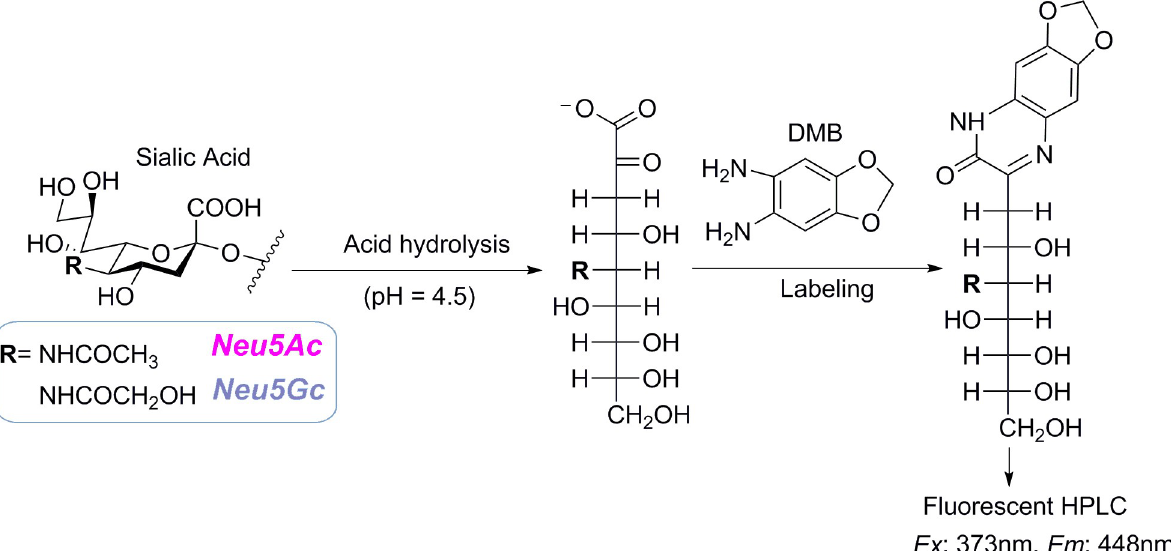
Fig 2. Scheme for hydrolytic cleavage of terminal sialic acid and its labeling for fluorescence detection. DMB : 1,2-diamino- 4,5-methylenedioxybenzene, Neu5Ac : N- acetylneuraminic acid, Neu5Gc : N- glycolylneuraminic acid.